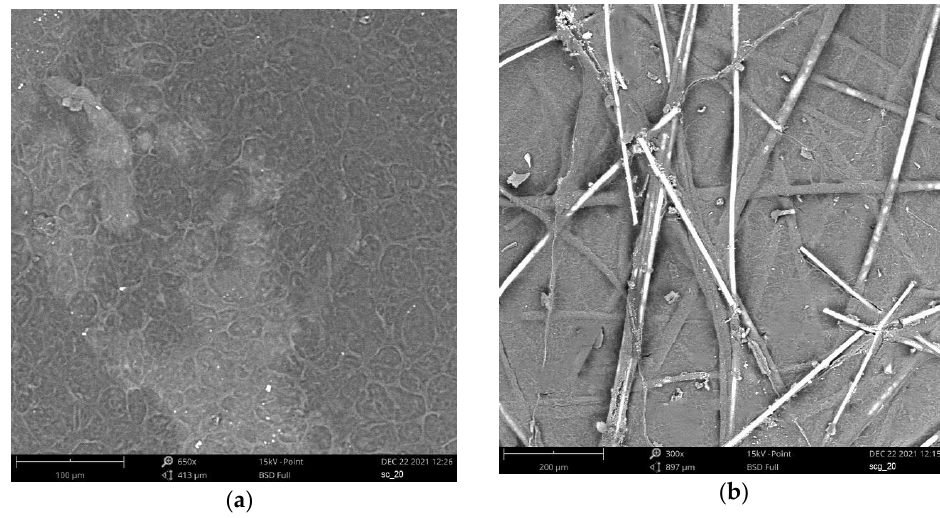
Figure 5. Scanning electron micrographs of starch films containing ( a ) 20 % glycerol, 3% NaMMT and 10% cellulose and ( b ) 20% glycerol, 3% NaMMT, 10% cellulose and fiberglass fabric.